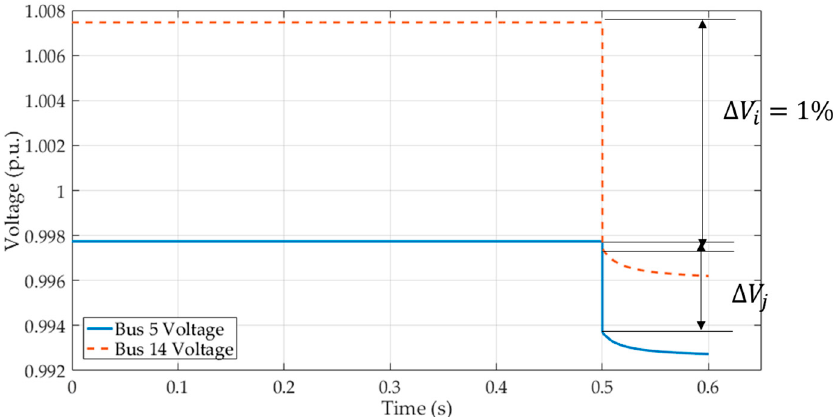
Figure 2. Sample case study of multi-infeed interaction factor ( MIIF ).